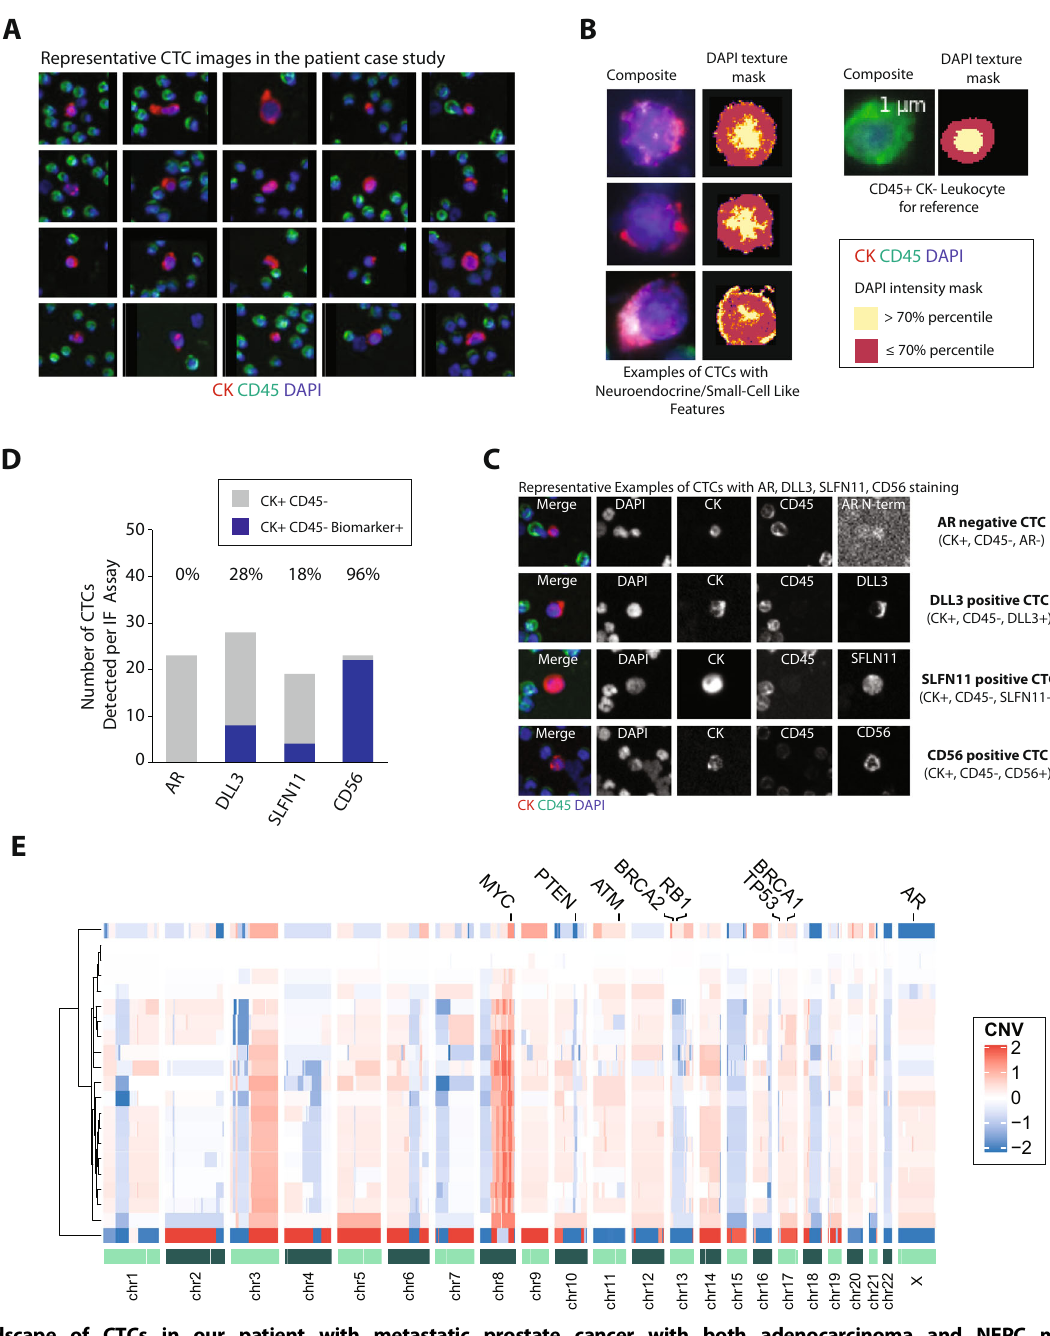
Fig. 2 Landscape of CTCs in our patient with metastatic prostate cancer with both adenocarcinoma and NEPC morphologies. A Representative images of CK + , CD45 − CTCs detected in our patient. B Representative CTCs with small-cell-like features (N/C ratio greater than 0.8 and area less than approximately 2× that of white blood cells. A mask of the DAPI channel, showing the top 30% in terms of intensity is shown to better visualize the observed texture patterns. A leukocyte is shown for comparison. C Representative images of CTCs stained with a 4th marker for AR, DLL3, SLFN11, or CD56. In the three-color composite image, blue represents 4 ′ ,6-diamidino-2-phenylindole (DAPI), and red is used for CK, green for CD45, and white for DLL3. Other images show the gray-scale intensity for each channel. D The number of total CTCs and CTCs expressing either AR, DLL3, SLFN11, or CD56. E Analysis of copy number pro fi les by single-cell low-pass whole-genome sequencing of